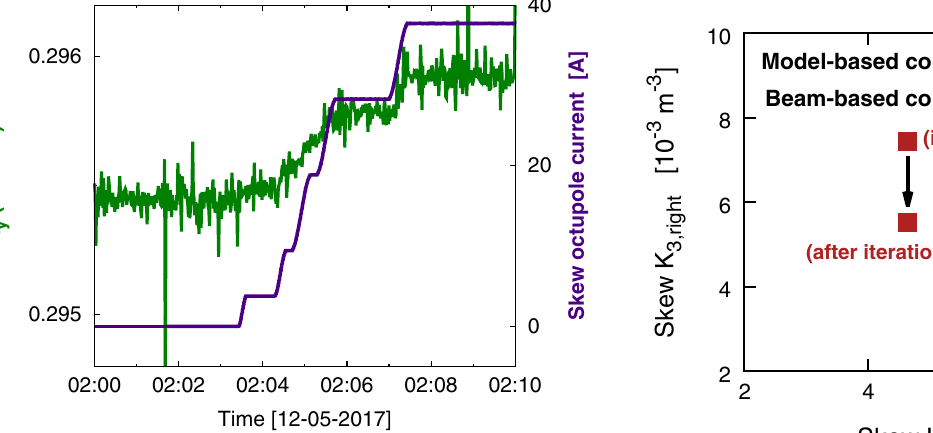
FIG. 22. Beam- and model-based correction of skew sextupole errors in the ATLAS (IR1)